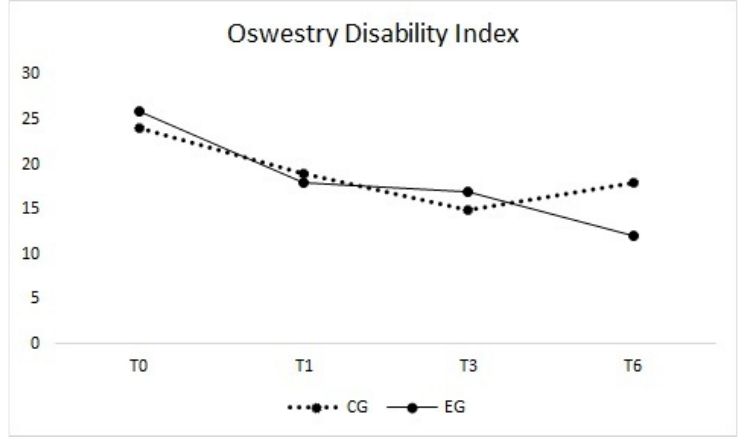
Figure 5. Oswestry Disability Index median scores at different time points.